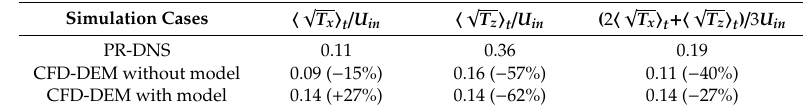
Table 3. Comparisons of the steady-state granular temperature between CFD-DEM simulations and PR-DNSs